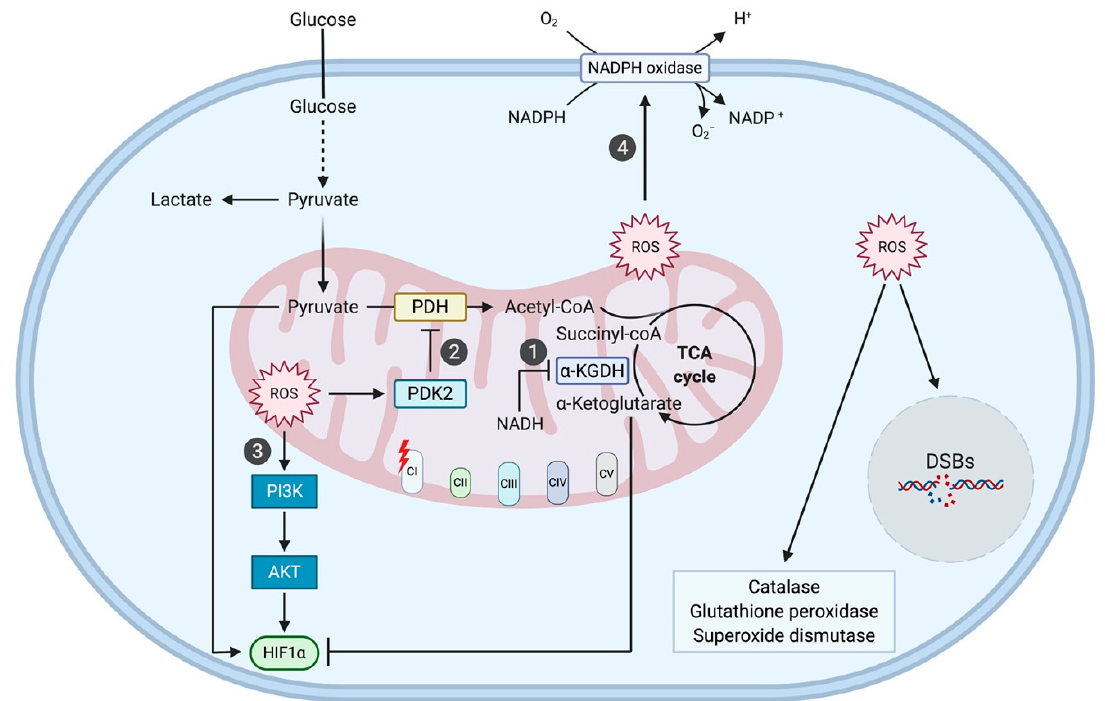
Figure 2. Effects of complex I mutations. ( 1 ) As a result of complete loss of complex I, NADH inhibits the TCA cycle enzyme α -ketoglutarate dehydrogenase ( α KGDH). This increases α -ketoglutarate levels and results in HIF1 α inhibition. ( 2 – 4 ) Complex I mutations increase reactive oxygen species (ROS) production. ( 2 ) ROS activate pyruvate dehydrogenase kinase (PDK2), which inhibits pyruvate dehydrogenase (PDH). Pyruvate accumulation activates HIF1 α . ( 3 ) ROS activate the phosphatidylinositol 3-kinase (PI3K) / protein kinase B (AKT) / hypoxia-inducible factor 1 alpha (HIF1 α ) signaling pathway. ( 4 ) Mitochondrial ROS activate the NADPH oxidase, which produces cytoplasmic superoxide. ROS lead to genomic instability via double-strand breaks (DSBs) and activate the cellular anti-oxidant